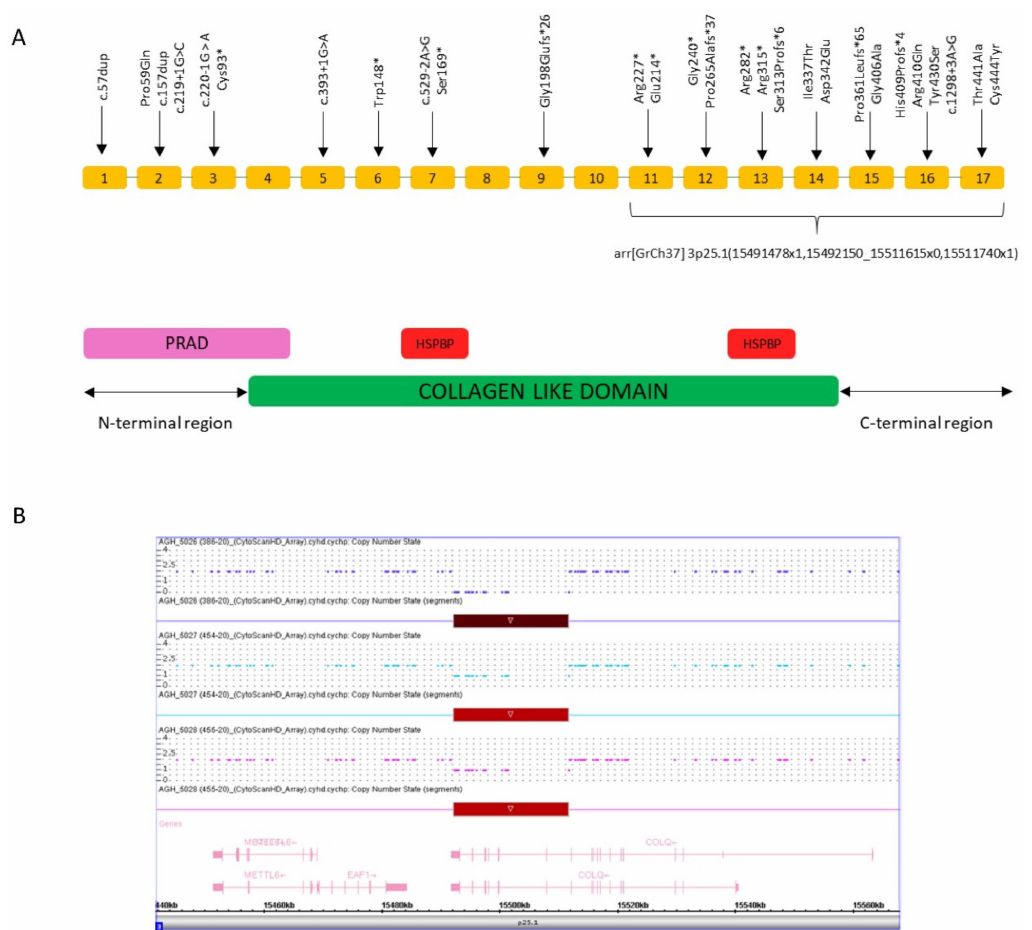
Figure 3. Schematic representation of the COLQ gene and results of single nucleotide polymorphism (SNP)-array analysis in the patient and his parents ( A ) COLQ exons with 28 published pathogenic variants (upper part) and the microdeletion described in this study (lower part). Three COLQ domains: (1) conserved domains of COLQ include an N-terminal proline-rich attachment domain (PRAD) that associates each COLQ strand with an acetylcholinesterase tetramer, (2) a central collagen domain that contains two heparan sulfate proteoglycan binding (HSPBP) domains, and (3) a C-terminal region needed for assembly of the COLQ strands in a triple helix. ( B ) Results of SNP-array analysis in the patient and his parents. The copy number state of each probe is drawn along chromosome 3 from 15.44 to 15.56 Mb (University of California Santa Cruz (UCSC) Genome Browser, buildGRCh37 / hg19). The upper panel represents the copy number state of the proband, the middle panel that of the father, and the lower panel that of the mother. Values on the Y -axis indicate the inferred copy number according the probes’ intensities. Red bars indicate the deletion identified in the patient (homozygous state, copy number = 0) and his parents (heterozygous state, copy number =